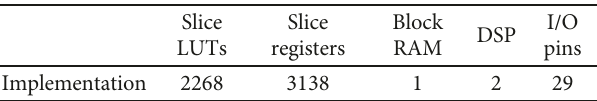
Figure 5: TC and ToA measuring device implementation. Table 3: FPGA resources needed to implement one single TC and ToA